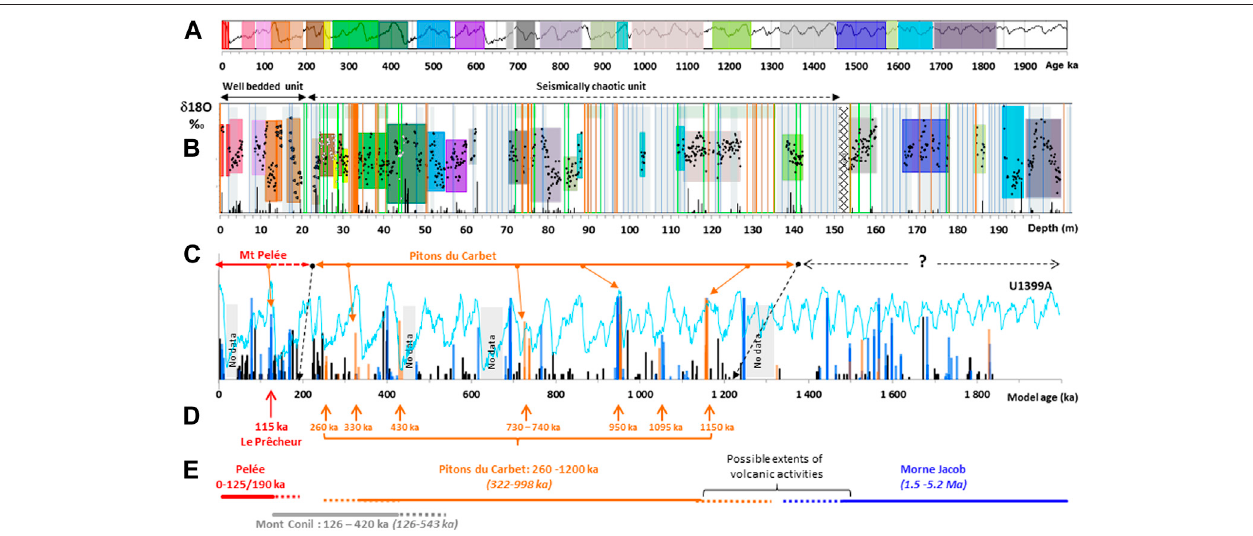
FIGURE15 | Chronological model ofthe evolution ofvolcanic activity inMartinique over the last 1.5 Ma. (The reader is referred tohigh-resolution fi gure on theweb version of this article for bene fi t). (A) LR04 reference curve for δ 18 O evolution of seawater. Color codes are arbitrary and used for comparison with U1399A stratigraphy (B) . (B) Stratigraphy and δ 18 O of hemipelagic sediments of core U1399A. Colored domains correspond to different hemipelagic units characterized by their δ 18 O patterns and their age range as de fi ned in (A) . Other symbols as in Figure 6 . (C) Reconstituted chronostratigraphy of volcanic events recorded in core U1399A. Symbols as in Figures 6 , 7C . Blue line: LR04 curve (unscaled) for comparison of volcanic activity (tephra, turbidites, and debrites) with high and lowstands of the sea level.Orangearrows: main fl ankcollapsesidenti fi edbydebrites and/or turbidites.Blackarrows: mainrestperiods delimitingvolcanic activities ofMtPeléeand Pitonsdu Carbet. (D) Scenario of the main fl ank collapses. Arrows: main fl ank collapses. (E) New model for the volcanic activities of Mt Pelée and Pitons du Carbet. Age ranges in brackets: previous data (K-Ar dating; Germa et al., 2010; Germa et al., 2011b). Mt Pelée activity and “ Le Prêcheur ” fl ank collapse are dated from the core U1397A ( Figure 12 ). Mt Conil and Morne Jacob activities are not well-constrained by our